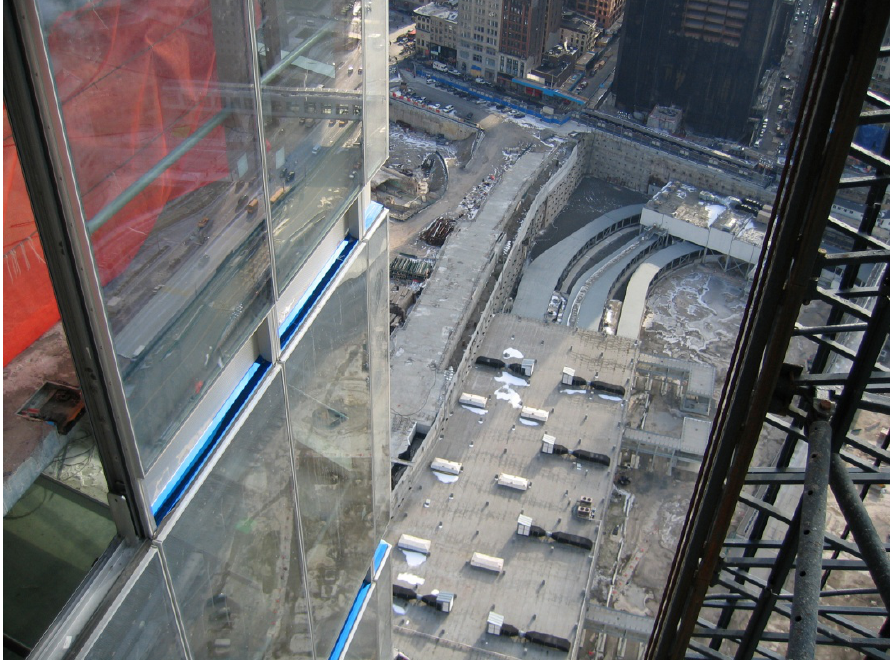
Figure 15: view of the blue reflectors during installation.